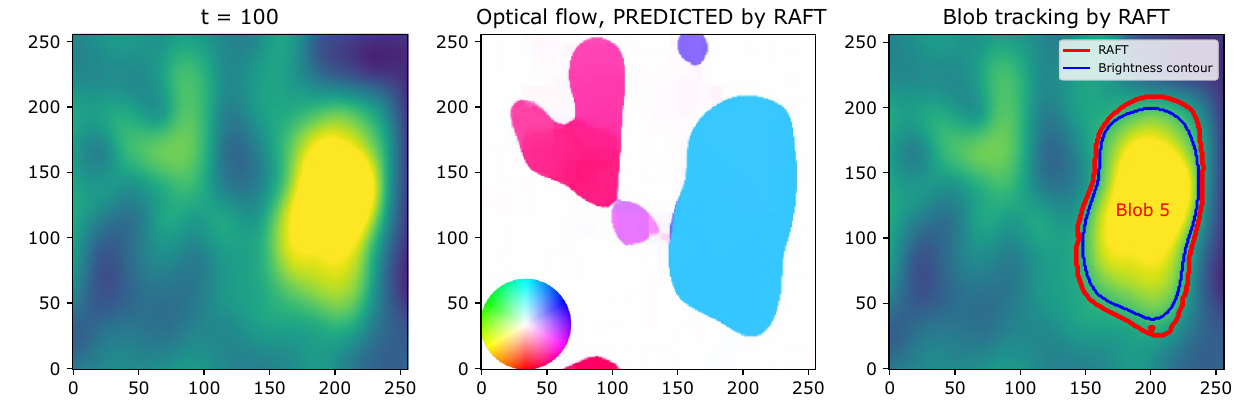
Figure 3. An example of blob tracking on experimental data. With the current frame (left) and the next frame as input, RAFT predicts optical flows for each pixel (middle). In the middle, the color of each pixel indicates the velocity (speed and direction) of the optical flow predicted, corresponding to the color palette shown at the bottom left. On the right, the red contour is drawn for the boundary of the pixels having non-zero optical flow in the central figure. The blue contour is the contour of 0.7 × B max where B max is the maximum (standardized) brightness inside the red contour, which is used for computing VIoU. The red contours chosen by several thresholds (VIoU > 0.8 , B max > 0.75 , lifetime > 15 frames) are only tracked. The blob ID (Blob 5) was assigned by Tracking-by-detection.